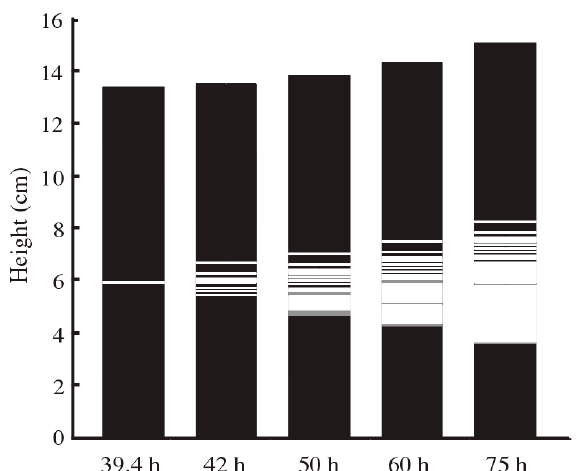
Figure 12. Histogram of ice lenses distribution at different durations of freezing (the white parts are ice lenses).